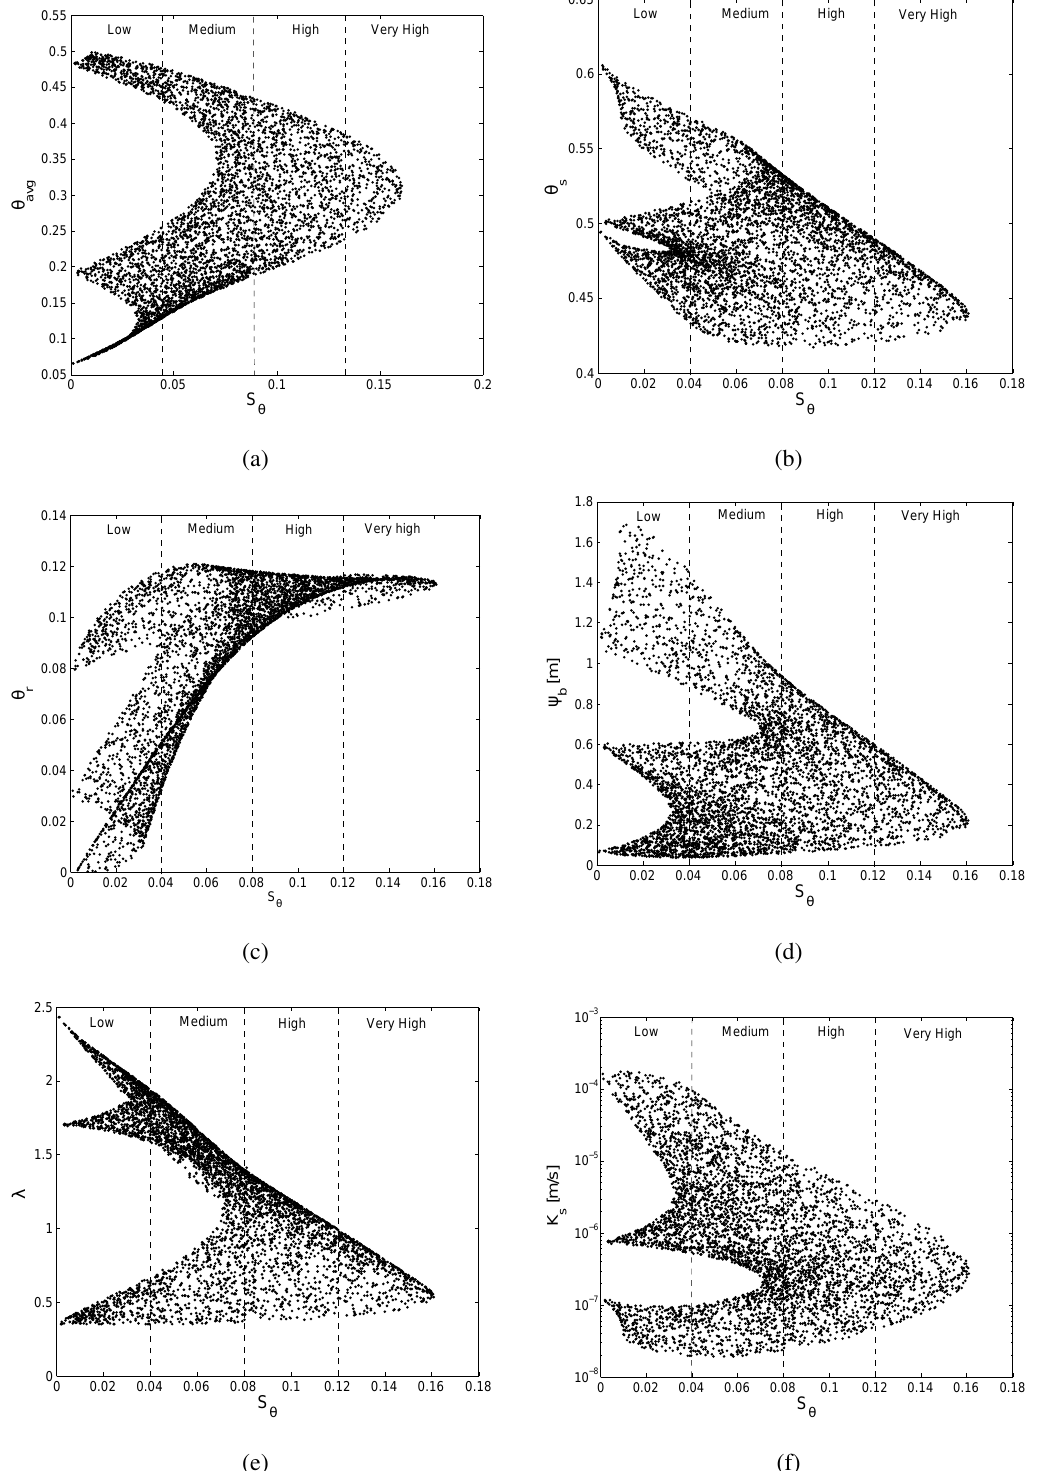
Fig. 8. Scatterplot between S θ and the soil hydraulic parameters θ s , θ r , ψ b , λ , K s (a–e) and the average simulated soil moisture content θ avg (5000 sampled textures).